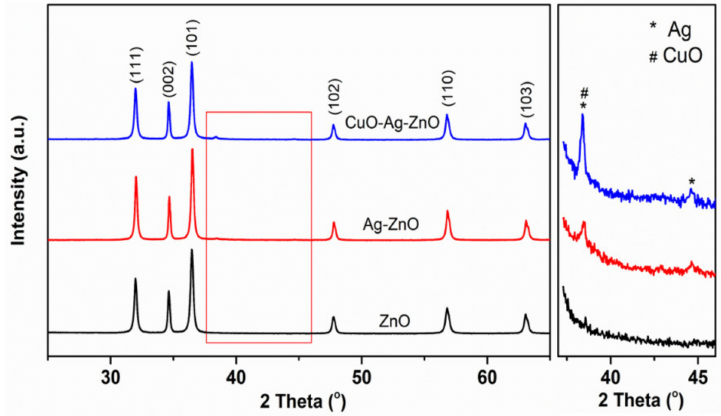
Figure 3. XRD diffraction patterns of as-prepared samples.